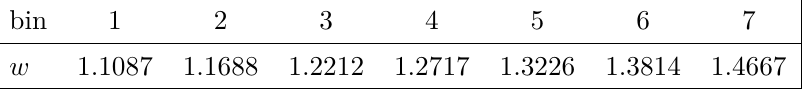
Table 1 . Binning scheme used for this measurement. Only the upper bound for each bin is presented. The lower bound on the first bin corresponds to w = 1